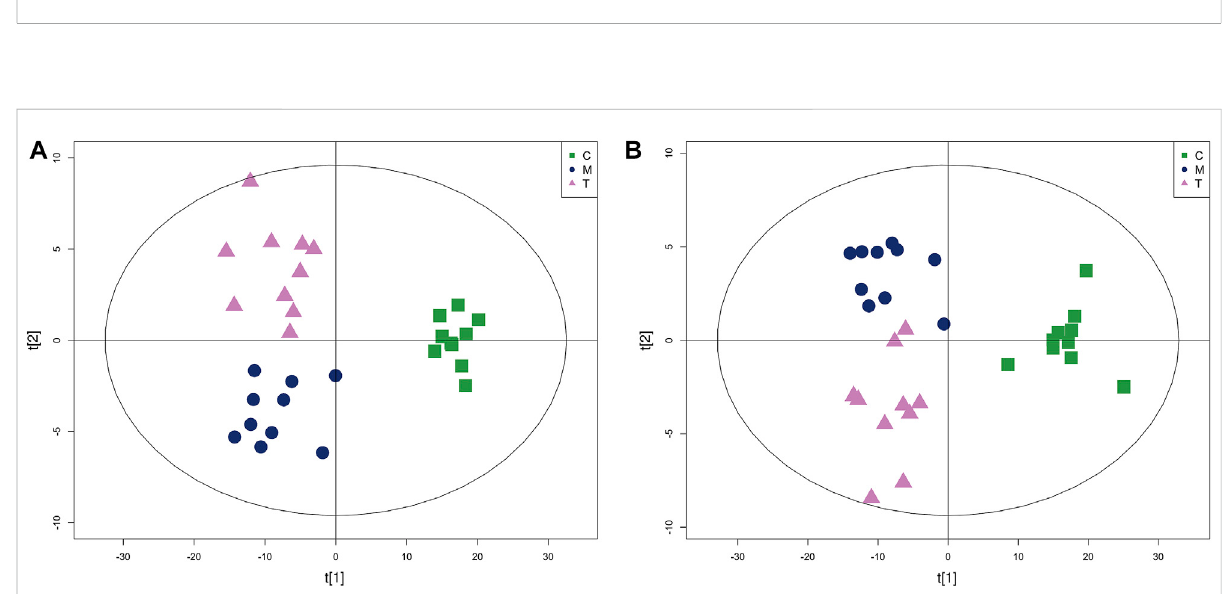
FIGURE 7 The PLS-DA score plot of group C, group M and group T in skin tissue metabolism pro fi le. (A) Positive mode and (B) Negative mode.